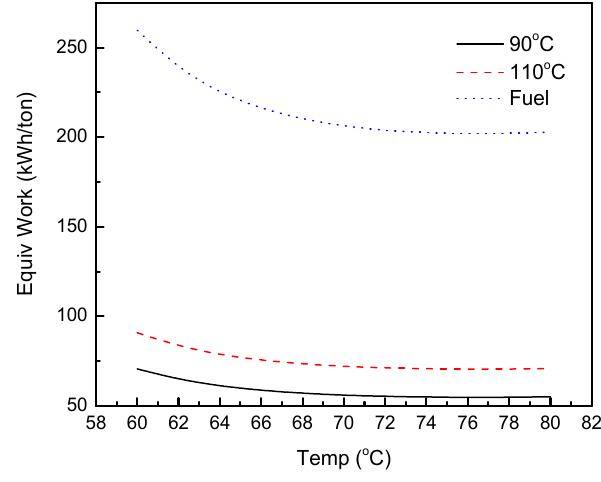
Figure 17. Equivalent work of the FO process using DP as the draw solute.